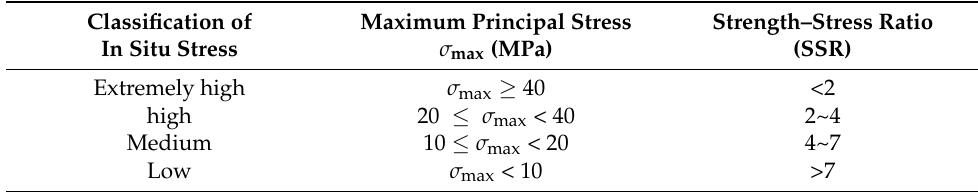
Table 2. In situ stress classification of rock